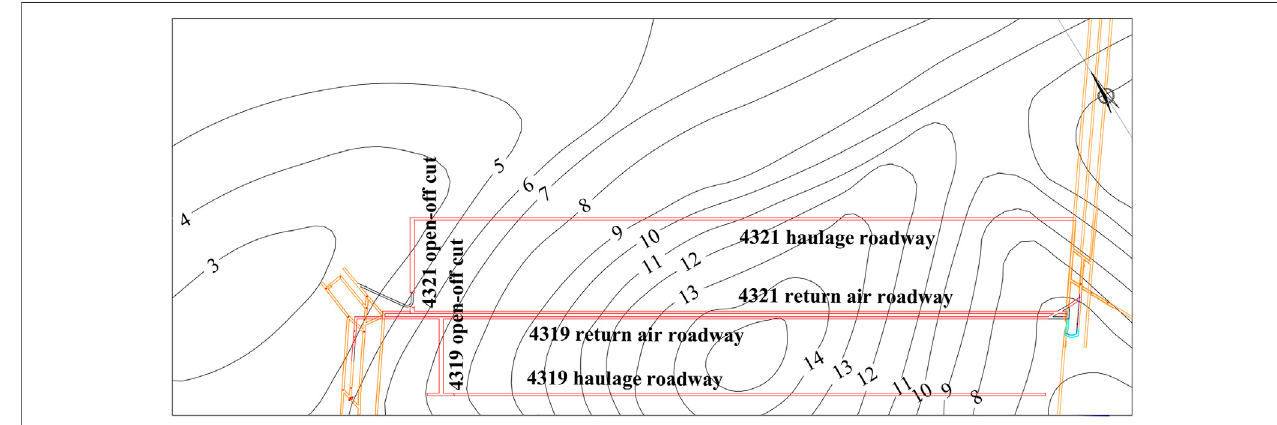
FIGURE 2 | Contour line of coal seam thickness on the 4,321 working face.